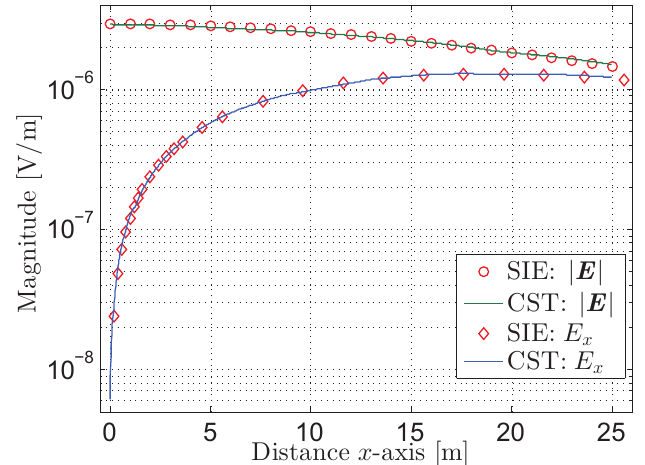
Figure 4. The total electric field and the electric field in x -direction at test point ( x ,0, − 60 ) . SIE: surface integral equation. CST: Computer Simulation